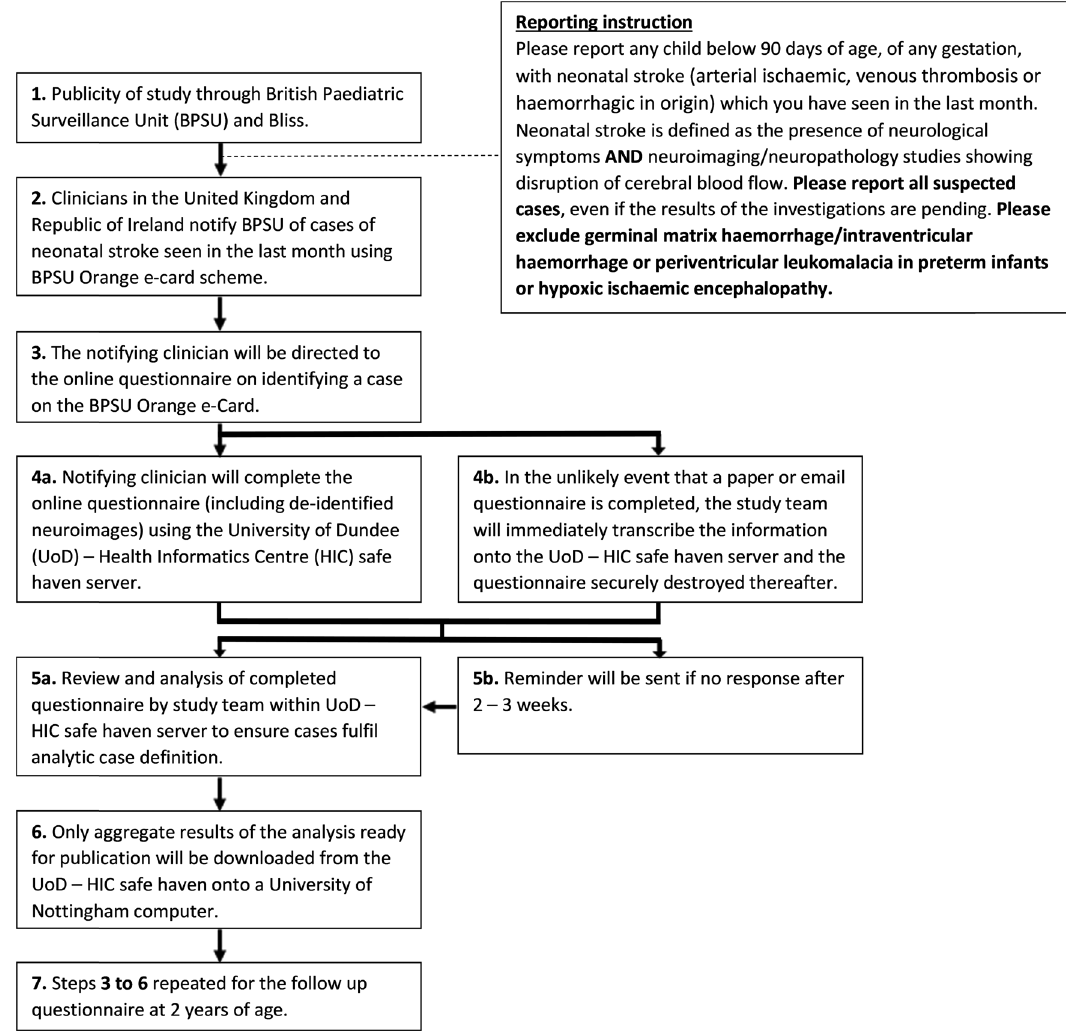
Figure 2: Flow diagram depicting the noti fi cation and data fl ow during the neonatal stroke surveillance